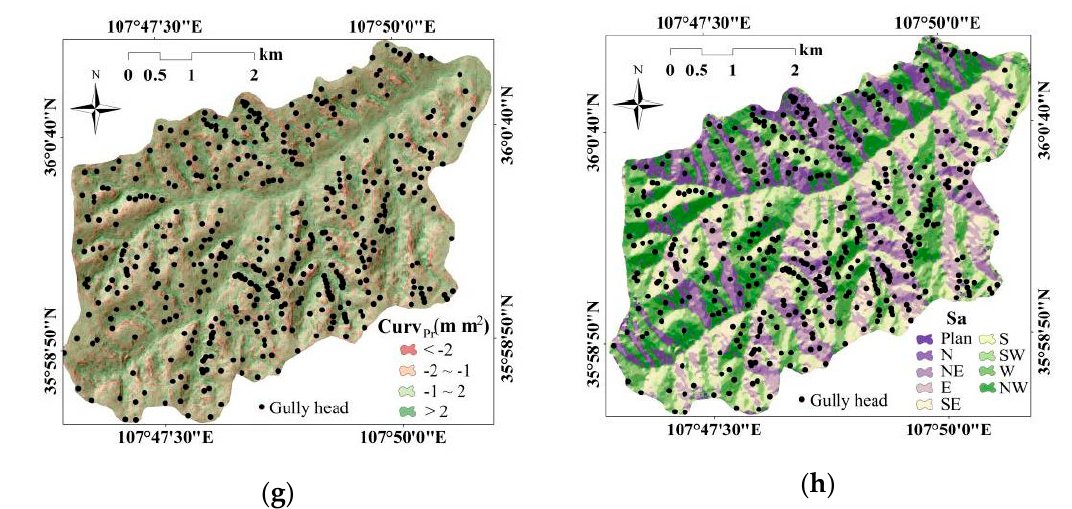
Figure 5. Terrain factor distribution maps of the research area: ( a ) slope angle (Sl); ( b ) catchment area (Ca); ( c ) topographical wetness index (TWI); ( d ) stream power index (SPI); ( e ) slope-length factor (LS); ( f ) plan curvature (Curv pl ); ( g ) profile curvature (Curv pr ); and ( h ) slope aspect (Sa).